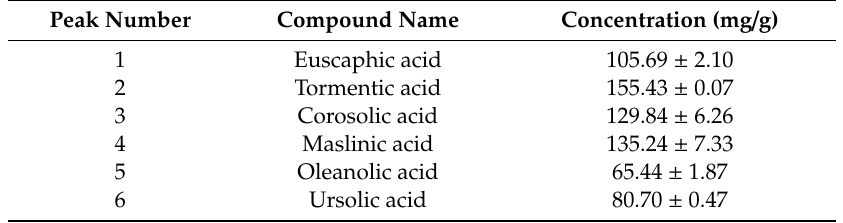
Table 1. Concentrations of six TAs analyzed by high-performance liquid chromatography–evaporative light scattering detection (HPLC-ELSD) (n =